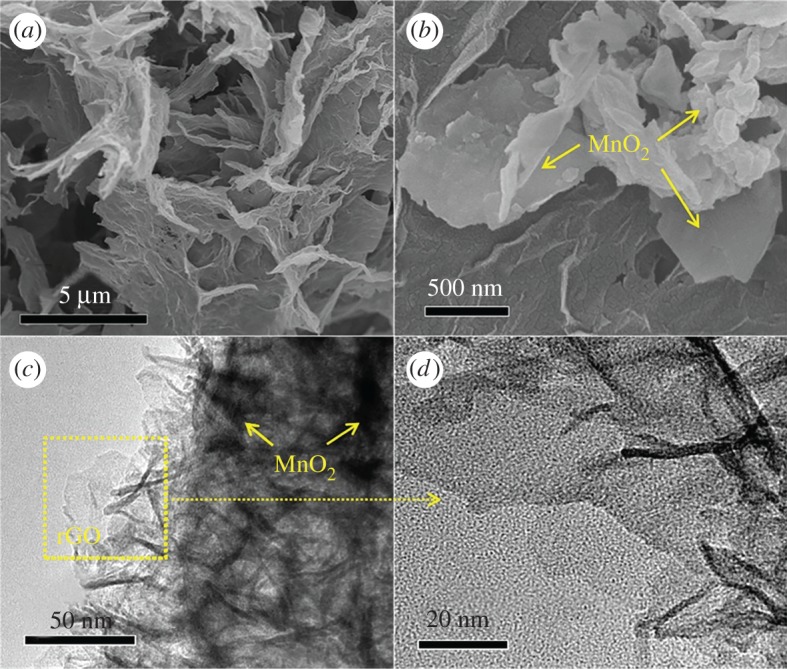
SEM images of GH (a) and MnO2/GH (b) and TEM images of the MnO2/GH sample (c,d). Adapted from ACS Publications.